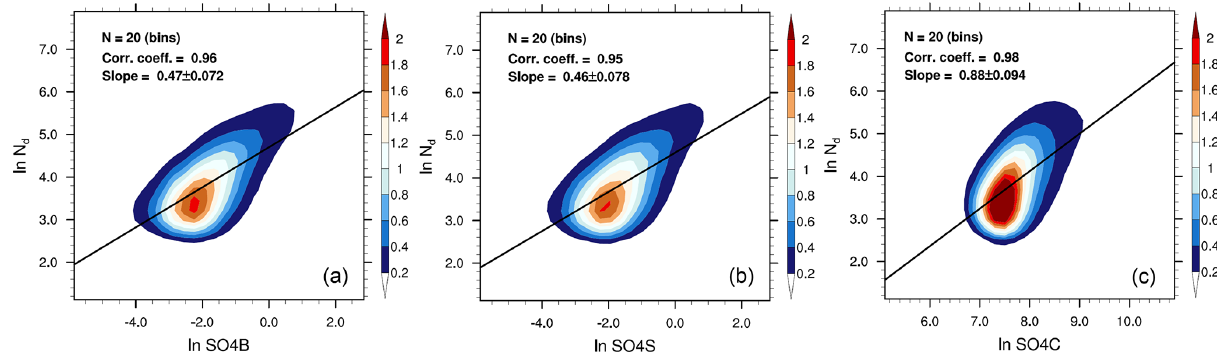
Figure 7. Two-dimensional probability density functions of ln N d versus (a) ln SO 4 B, (b) ln SO 4 S, and (c) ln SO 4 C for the period 2006– 2009. Sample numbers ( N ), correlation coefficients, and regression slopes with 95% uncertainty estimates (according to Student’s t test) for pre-binned SO 4 - N d pairs are displayed in the upper left of each